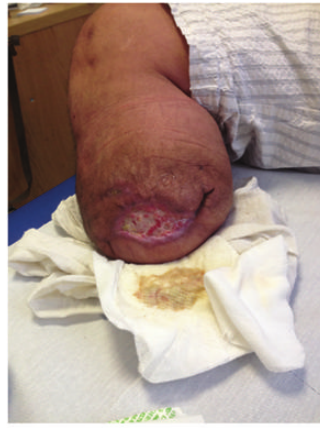
Figure 1: Stage I at 1st week.